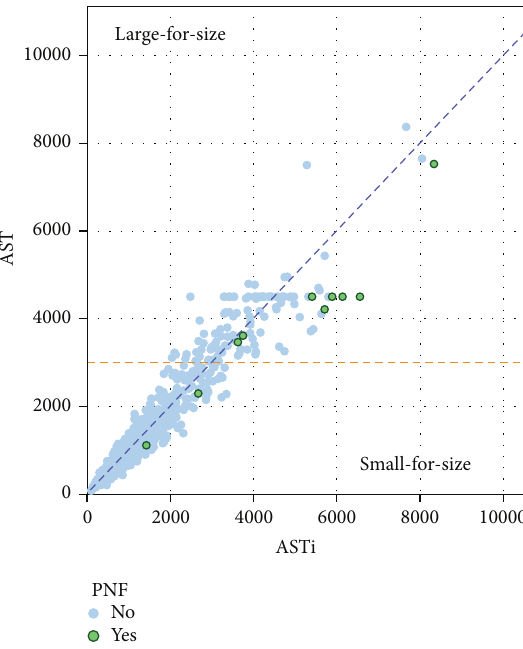
Figure 1: Scatter plot between AST and ASTi with or without sub- sequent development of PNF. Scatter plot showing the relationship between peak AST and size-adjusted AST (ASTi) for cases with or without subsequent development of PNF. Diagonal blue dot line shows 1: 1 correlation between AST and ASTi. All the cases on the line had no size mismatch between donor and recipient. Cases above this reference line had a large-for-size graft and below the line had a small-for-size graft. All cases of PNF had small-for-size donor, and severity of graft damage may be underestimated by unadjusted AST. Orange dot line is reference line of AST 3,000 IU/L, which is currently used for diagnosis of PNF by